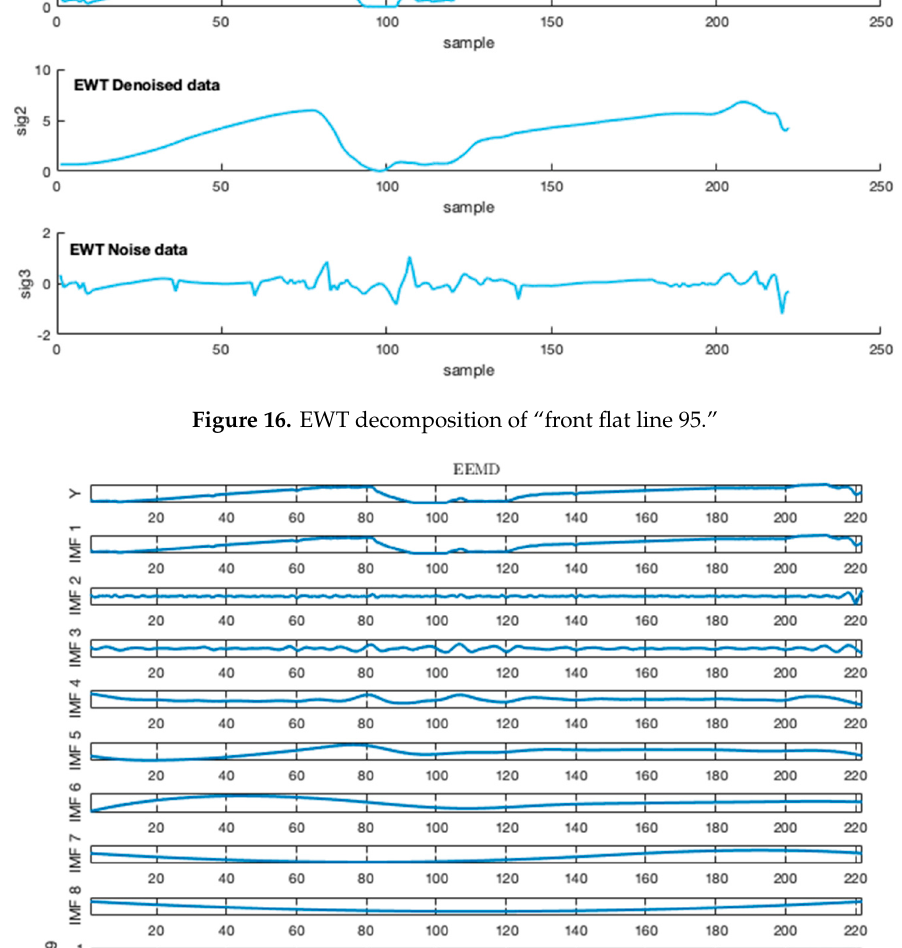
Figure 17. EEMD decomposition of “front flat line 95.”